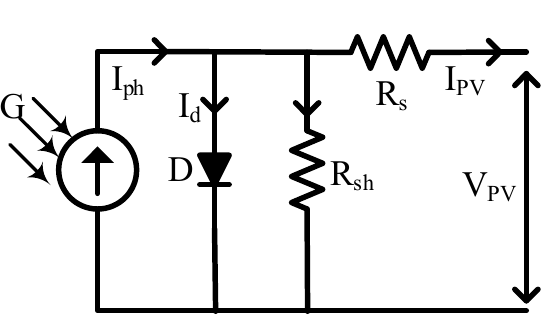
Figure 4. Solar cell model.